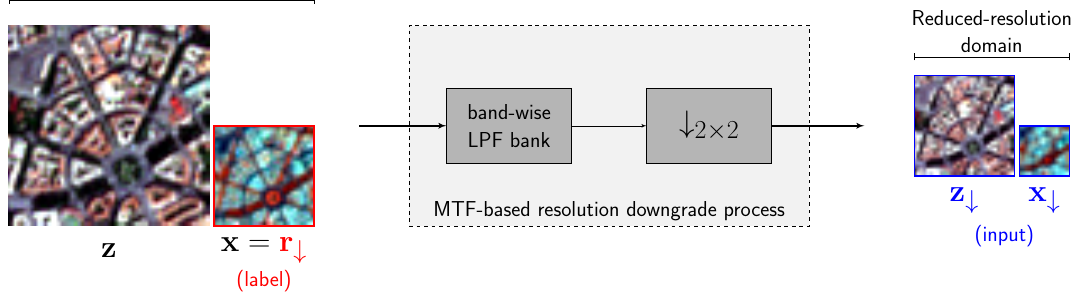
) ; r ) using Wald’s protocol. All images are shown in , z ↓ ↓ ↓